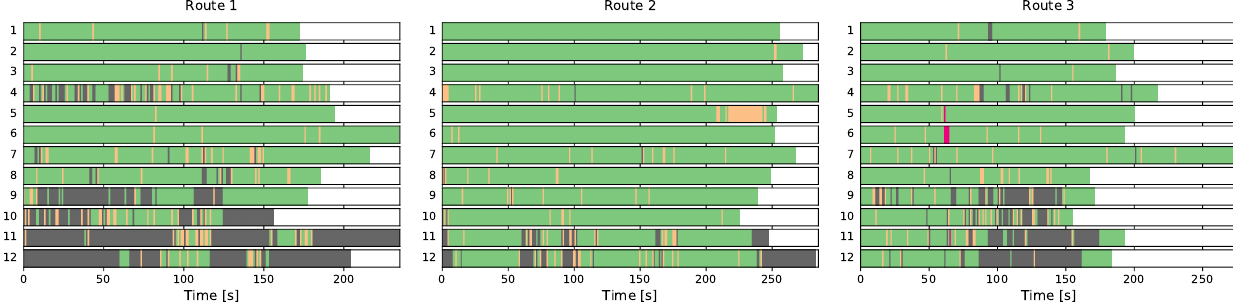
Figure 10. Results of the device placement classifier for the three test routes and 12 participants each (green, IN_FRONT ; yellow, IN_HAND_SWINGING ; red, IN_PHONE_CALL ; grey, IN_POCKET